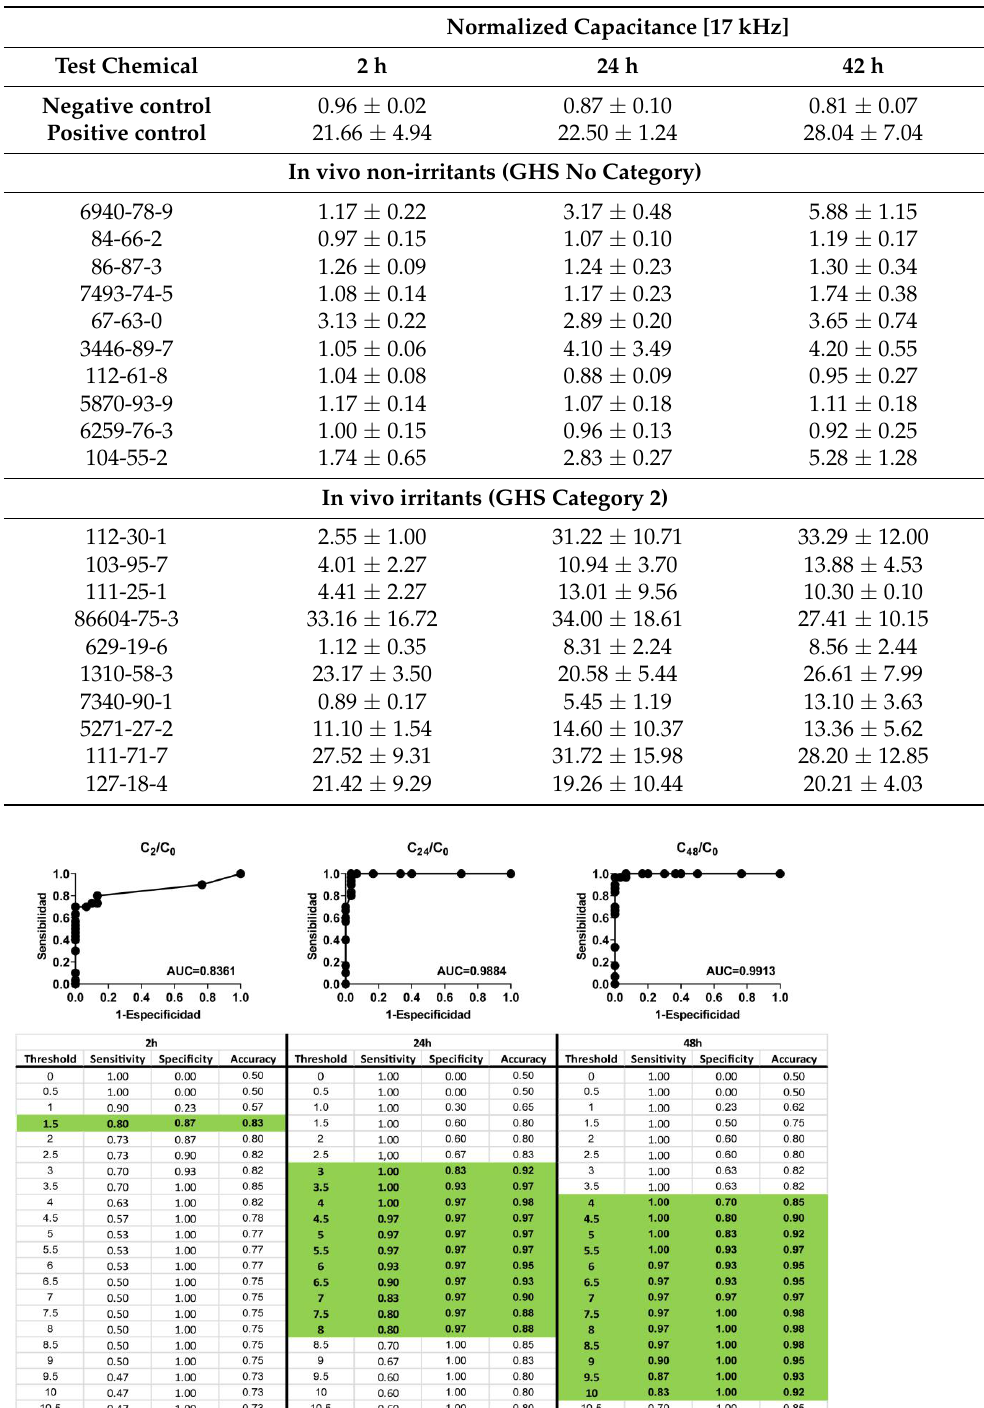
Table 3. Normalized capacitance data at 17 kHz after chemical exposure.